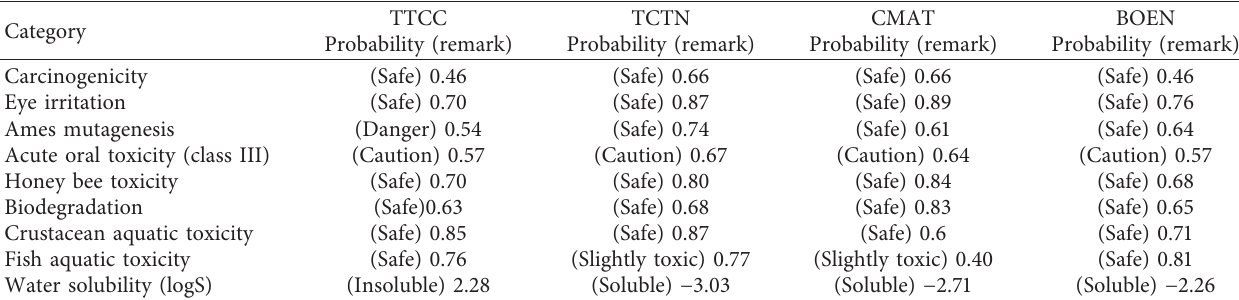
Table 3: Predicted ecotoxicity of the studied novel